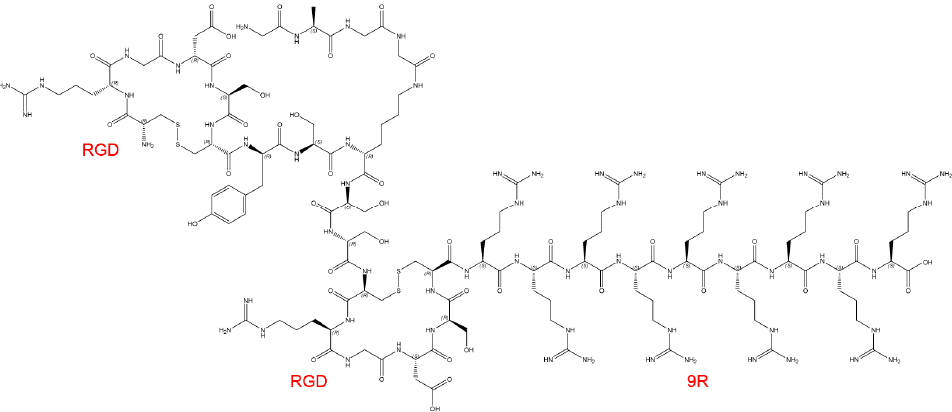
Figure 1. The chemical structure of c(RGD) 2 -9R, a chimeric peptide of cyclic RGD dimer targeting integrin α ν β 3 conjugated with 9R. The chimeric peptide c(RGD) 2 -9R was synthesized by adding